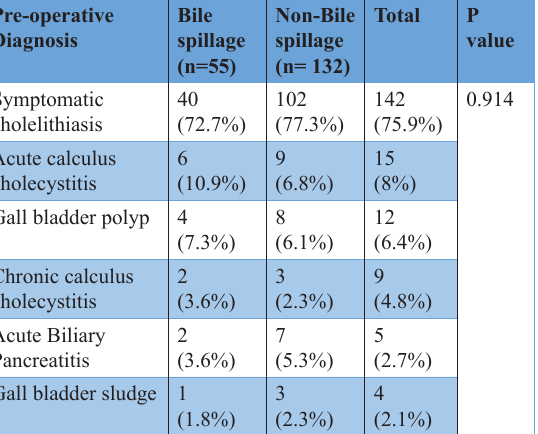
Table 3. Surgical site infection (SSIs) in patients with bile spillage and non-bile spillage during laparoscopic cholecystectomy.